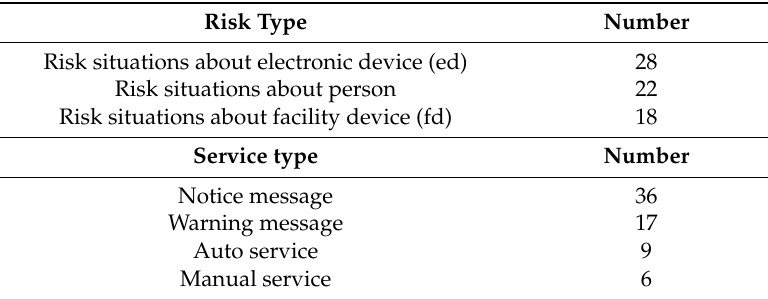
Table 7. Typical simple cases related to home